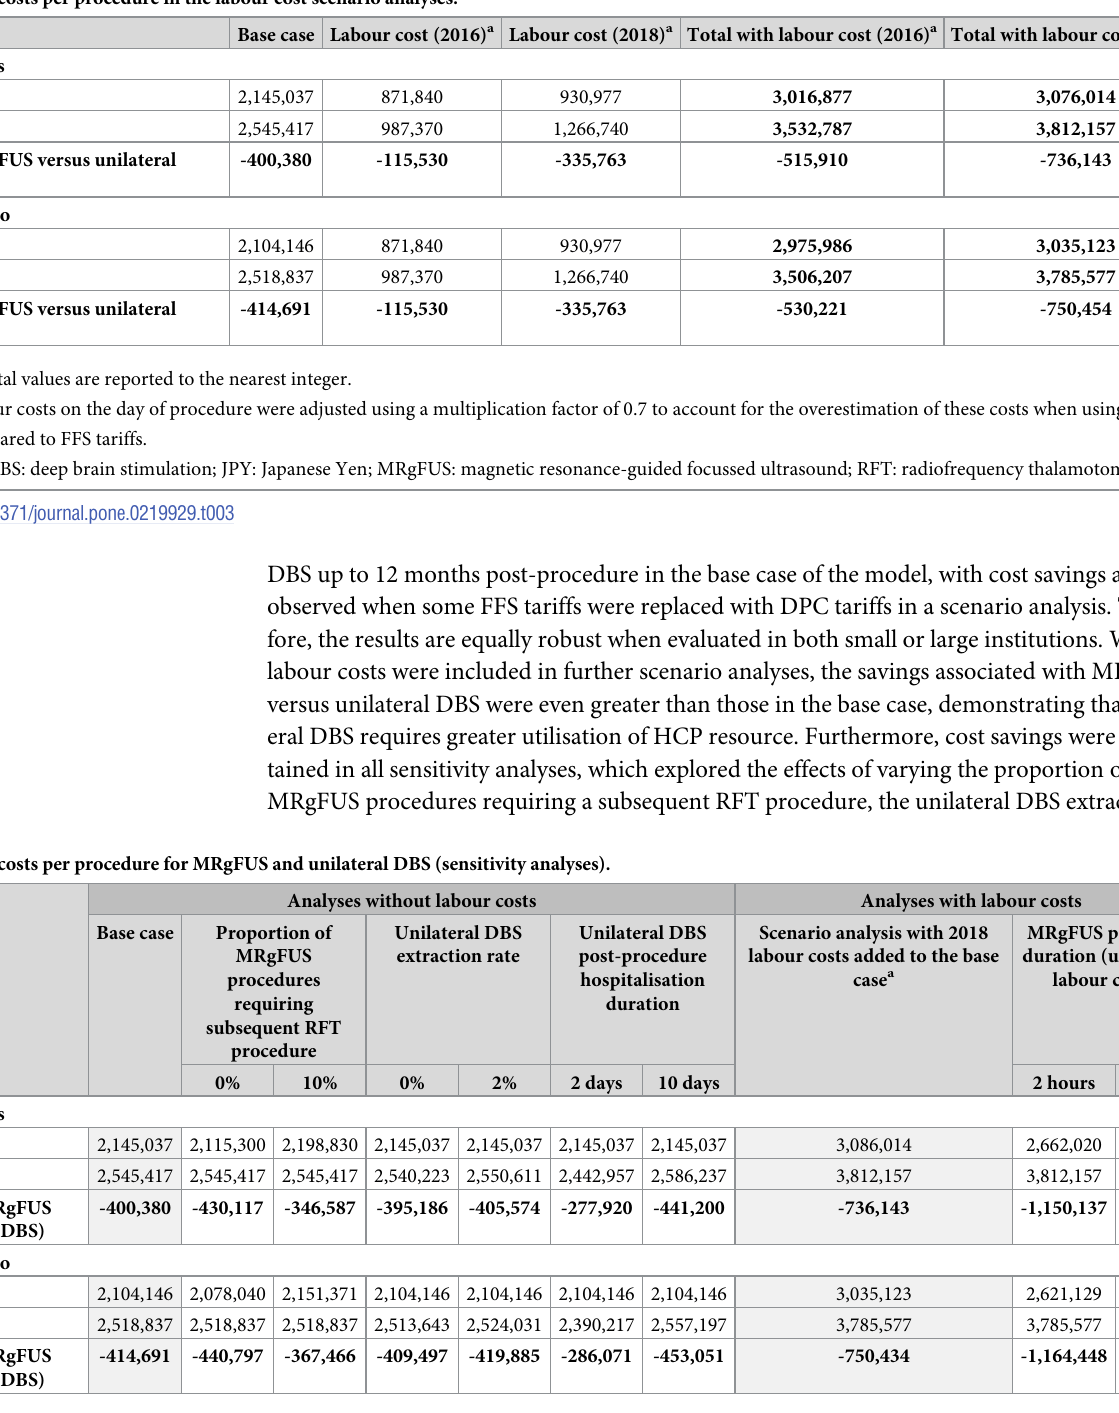
Table 3. Overall costs per procedure in the labour cost scenario analyses.